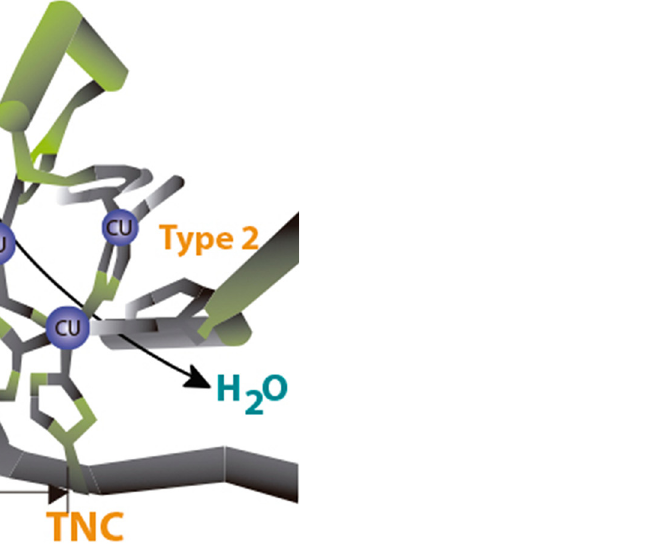
PLOS ONE | DOI:10.1371/journal.pone.0132181 July 21,